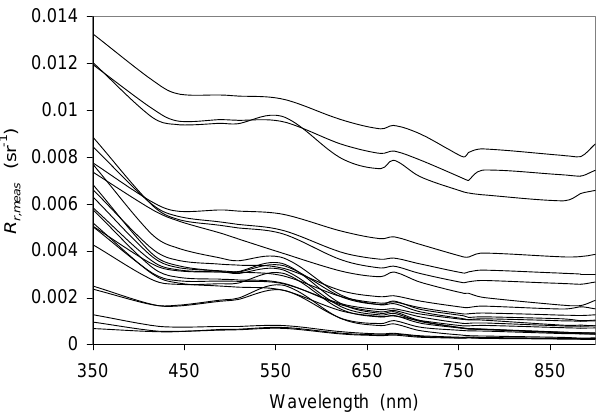
Figure 2. Spectral distribution of the ratio L r,meas /L ua